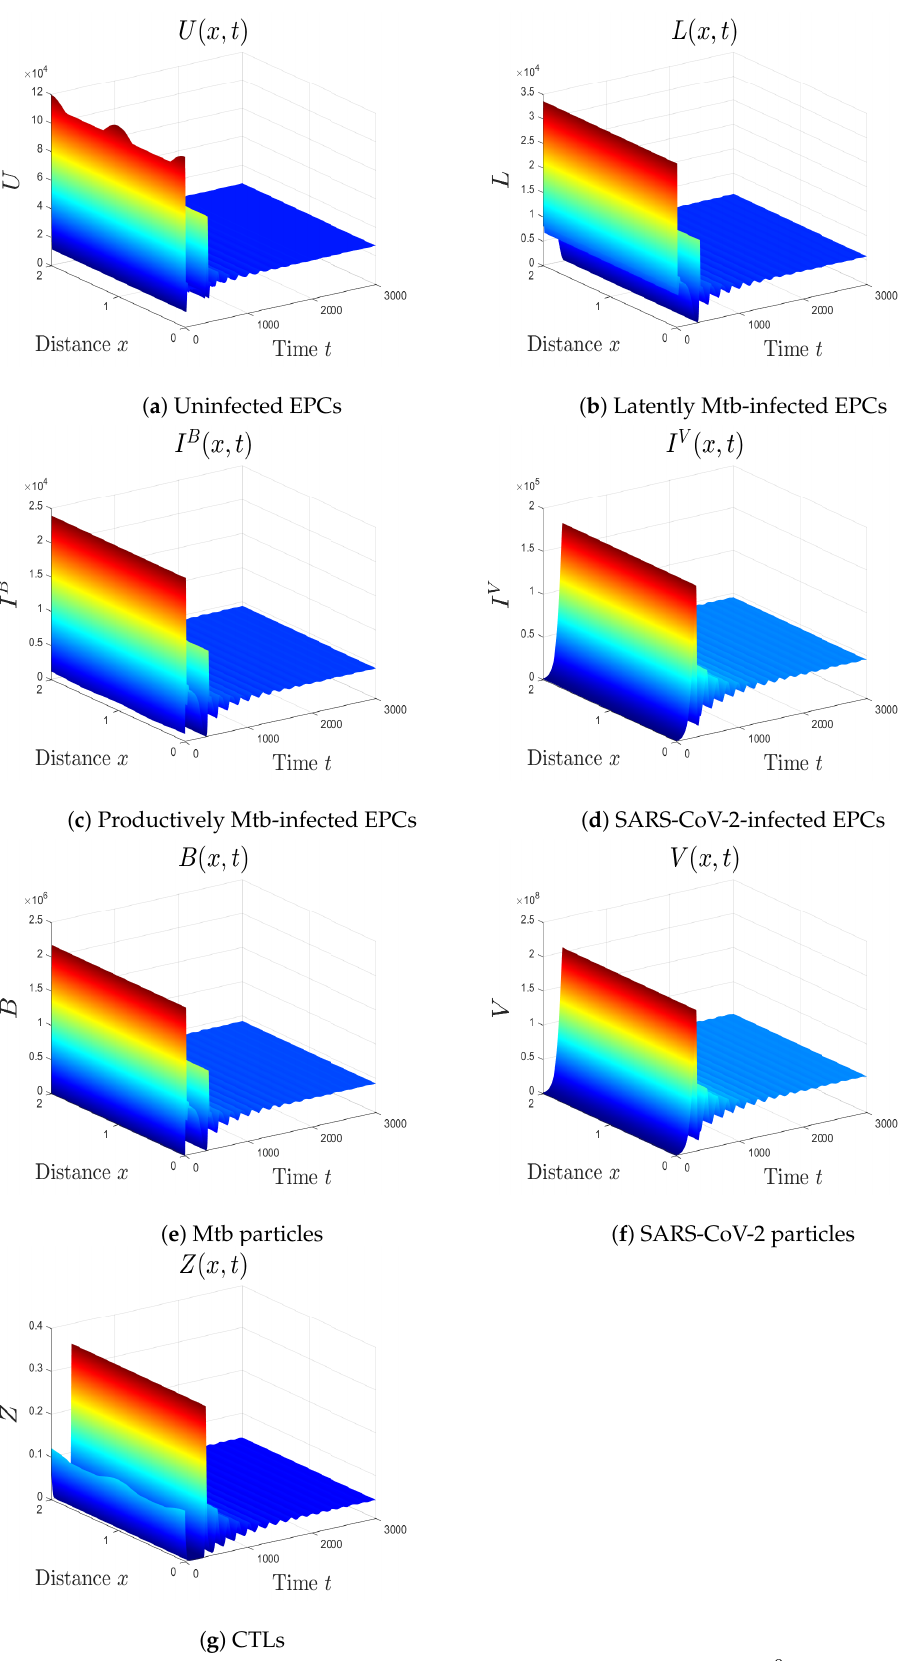
Figure 6. The numerical results of system (1) for η 1 = 2 × 10 − 7, η 2 = 1 × 10 − 9 , and ω = 2 × 10 − 6 . (cid:0) The equilibrium E 5 = 27,125.6,5712.6,4380.44,45,619.6,421,196,5.322 × 10 7 ,0.043